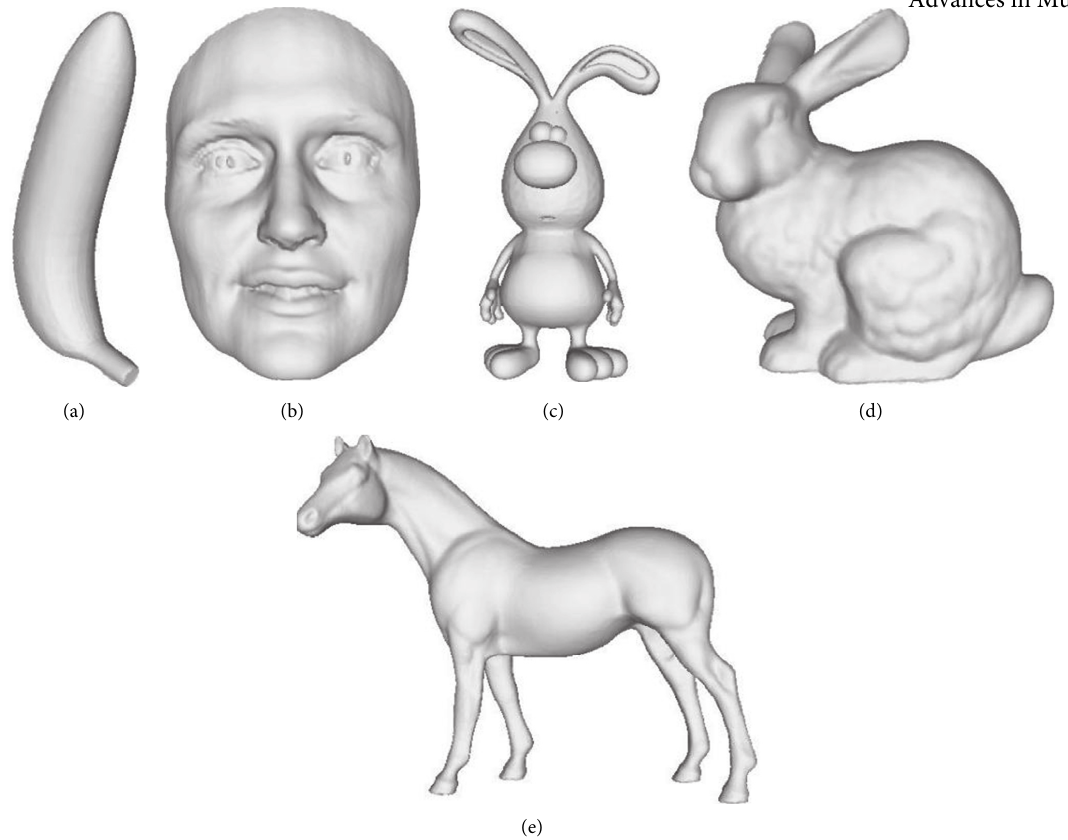
Figure 5: Models used in the experiment. For each model, the numbers in parentheses indicate the number of points. (a) Banana (25k).